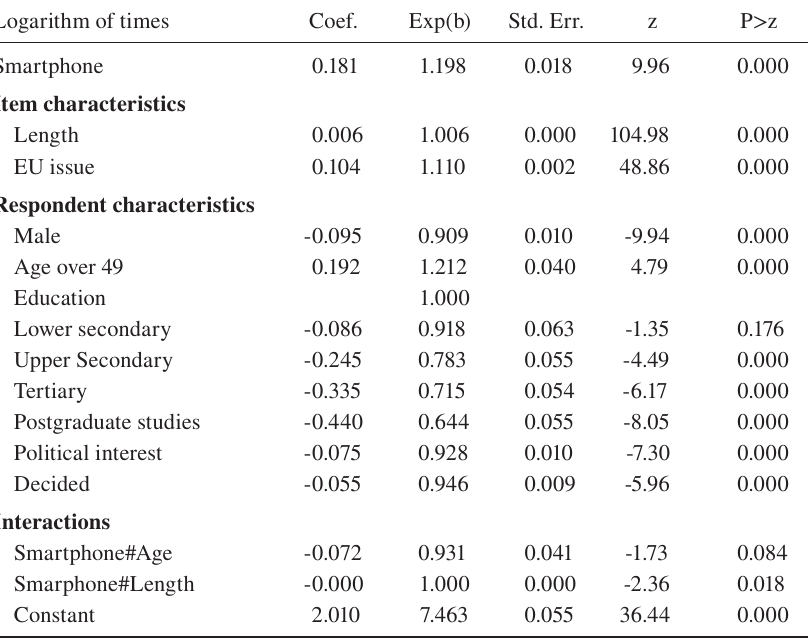
Table 2 Multilevel model coefficients and exponential coefficients Logarithm of times